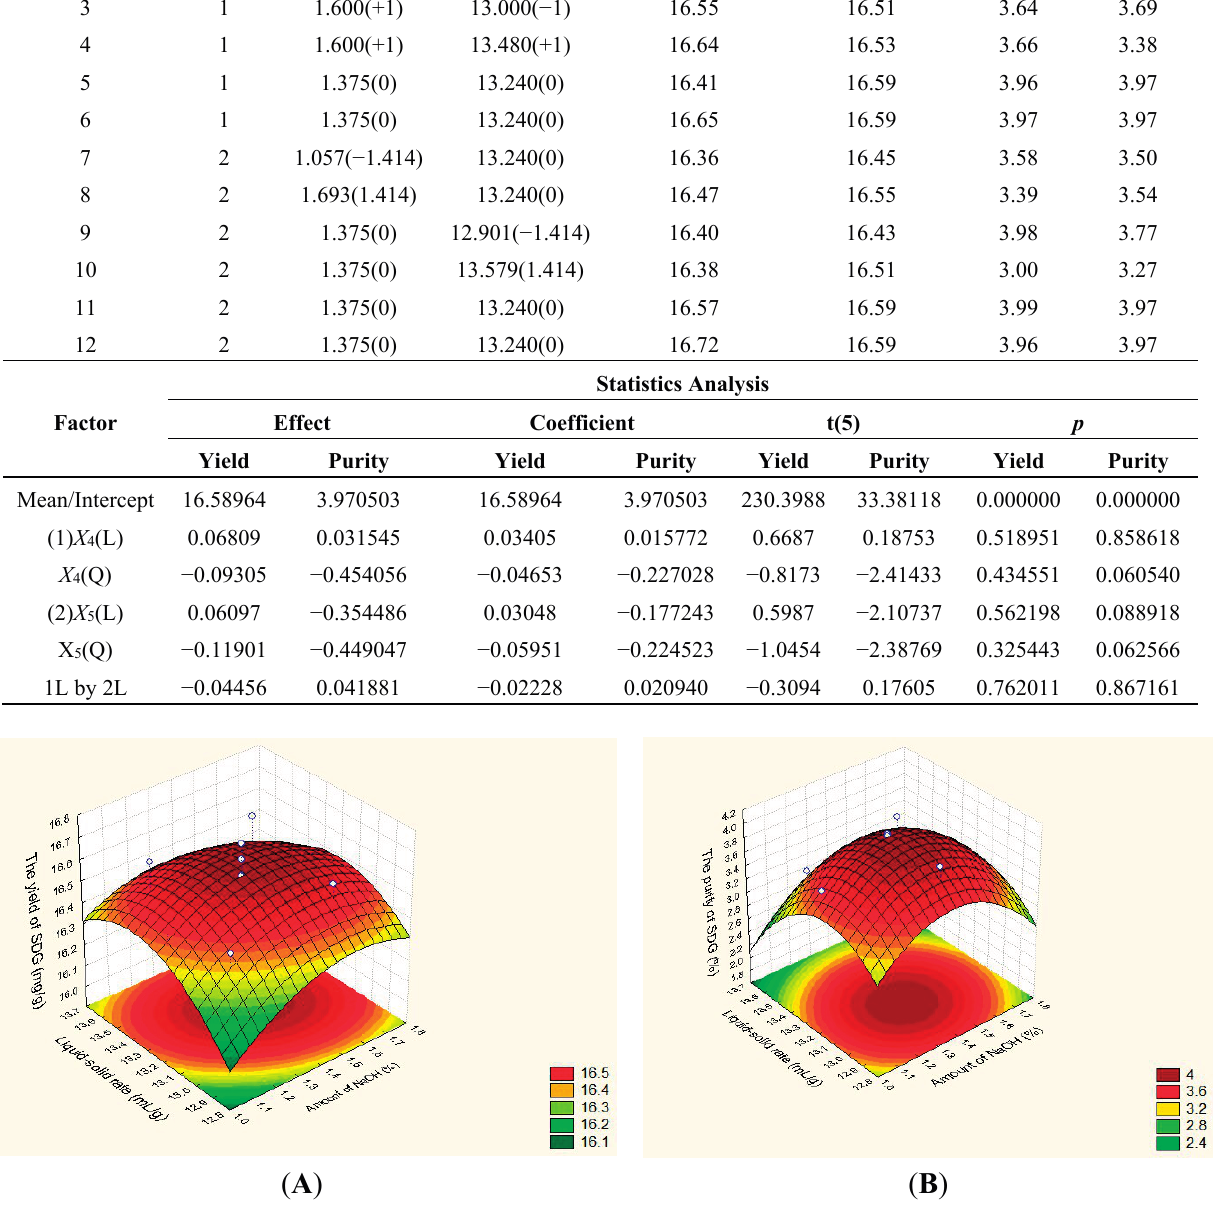
Figure 1. The response surfaces representations for SDG yield ( A ) and purity ( B ) in flaxseed